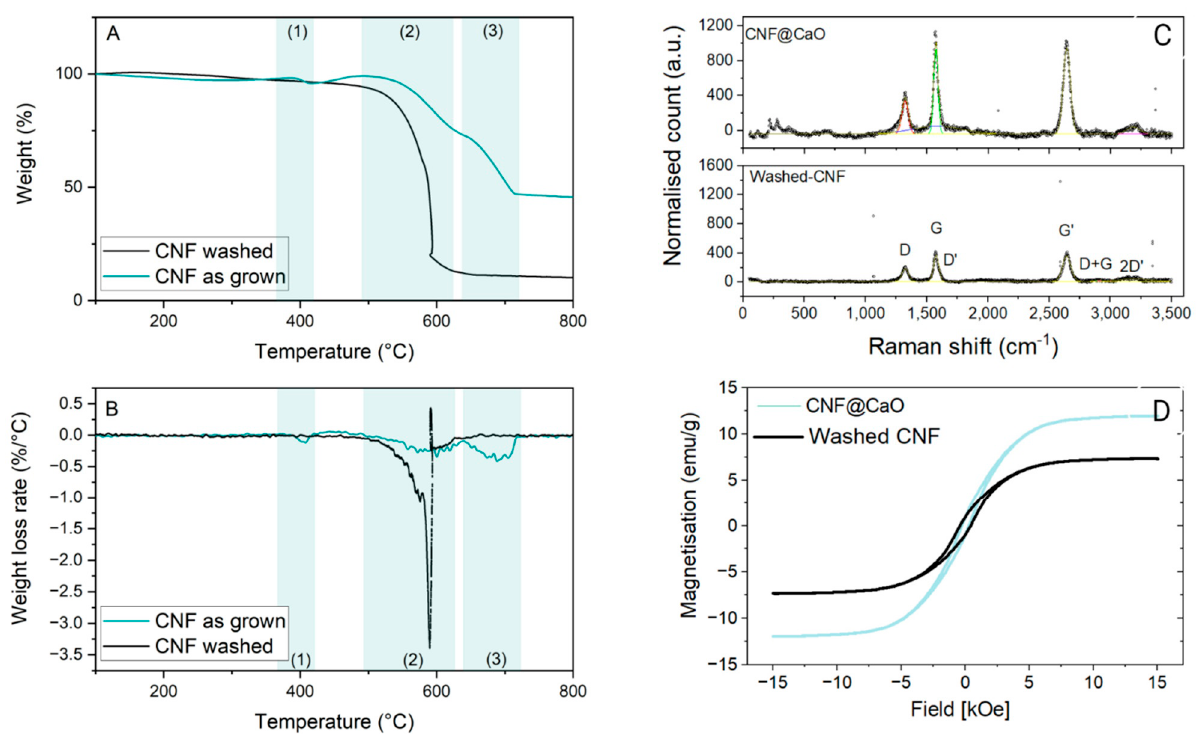
Figure 5. Characterisation of CNF@CaO as produced and CNF after acid washing. ( A ) Thermogravimetric analysis of as-grown CNF in the surface of CaO (teal) and acid-washed nanomaterial, purified for the removal of CaO (black); ( B ) Weight loss rate for the as-grown CNF (purple) and purified CNF (teal); ( C ) Raman spectra of CNF@CaO (top) and CNF—washed (bottom); ( D ) Magnetisation curve of CNF@CaO (teal) and CNF—washed (black).